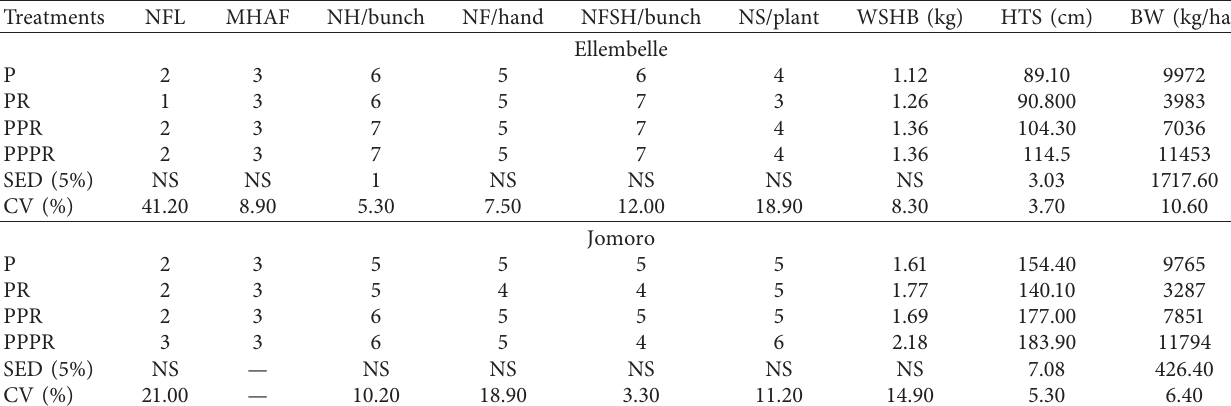
Table 7: Yield and yield components of plantain at harvest under various intercropping treatments at Ellembelle and Jomoro. Treatments